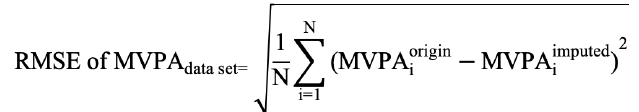
Table 1. Baseline characteristics of the data sets.